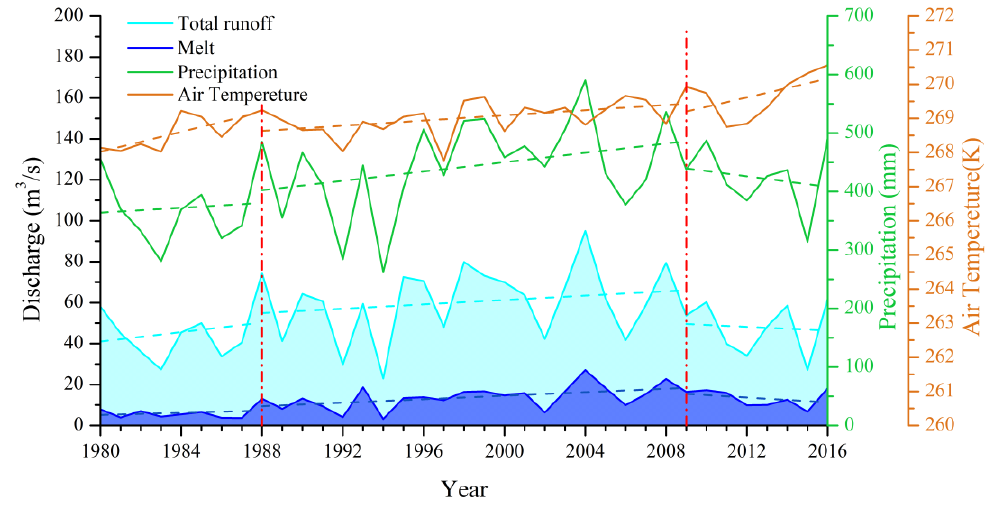
Figure 11. Variations of annual lake inflow, melt, precipitation, and air temperature from 1980 to 2016. Table 4. Changing rates of runoff, melt, precipitation, and air temperature in different periods.